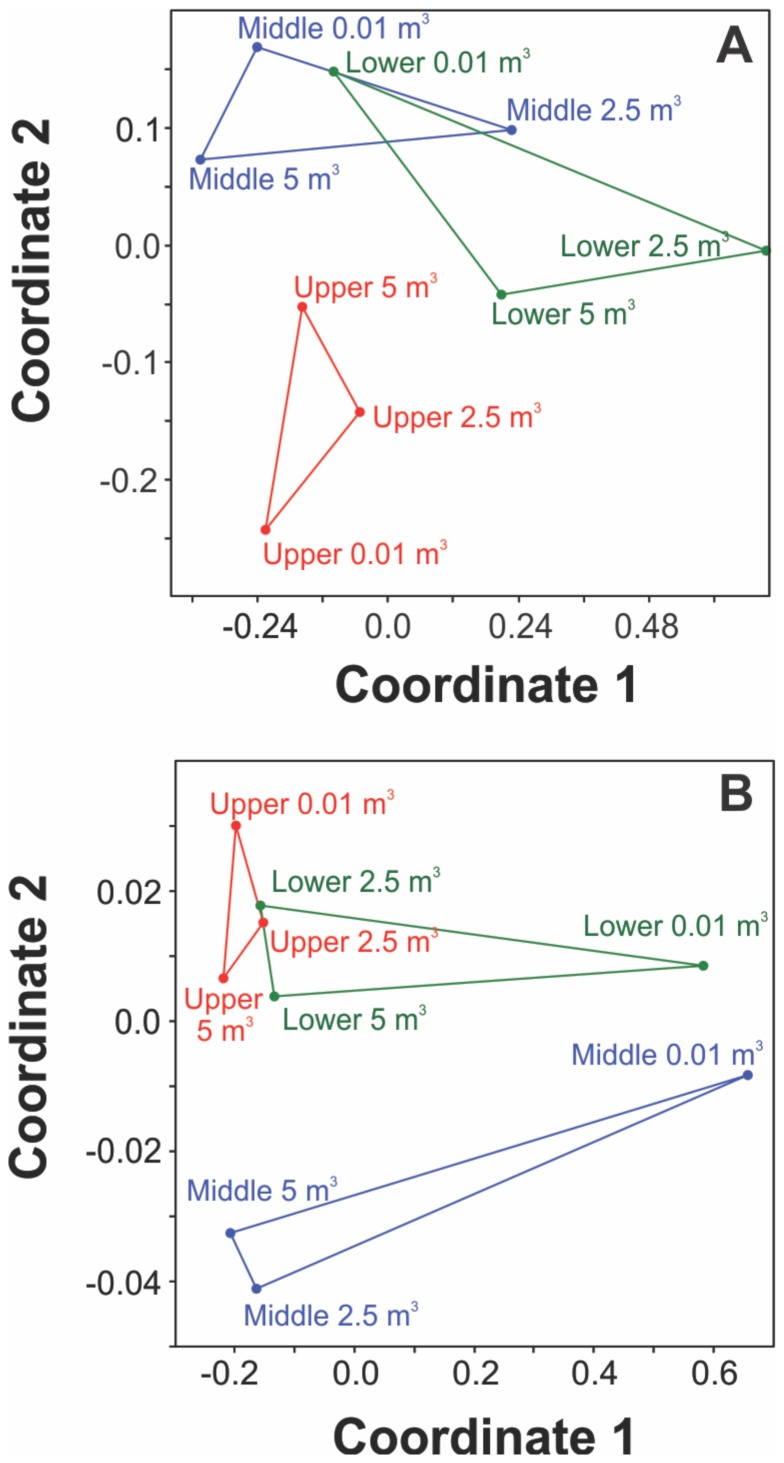
TRFLP profiles at TFM for (A) planktonic bacteria (B) particle associated bacteria.Non-Metric Multidimensional Scaling (NMDS) plot with solid lines illustrating the interval, but not statistical significance.